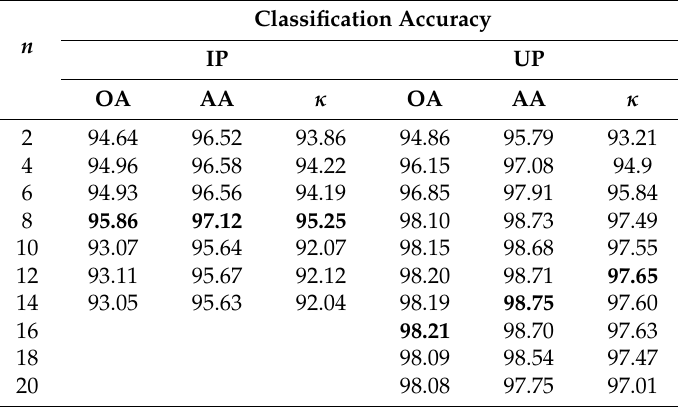
Table 6. Classification accuracy (%) by the SVM-SSHK method under different values of n for the IP and UP images. The best accuracies are indicated in bold in each